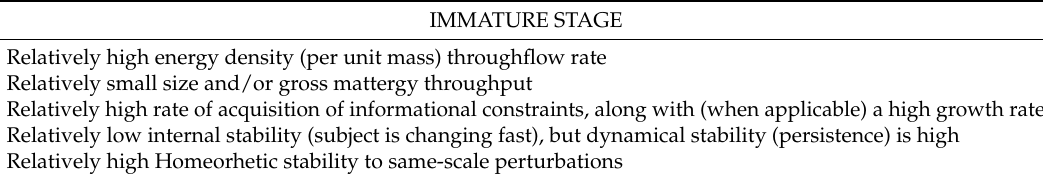
Table 1. Developmental Stages of Dissipative Structures (from Salthe, 15). IMMATURE